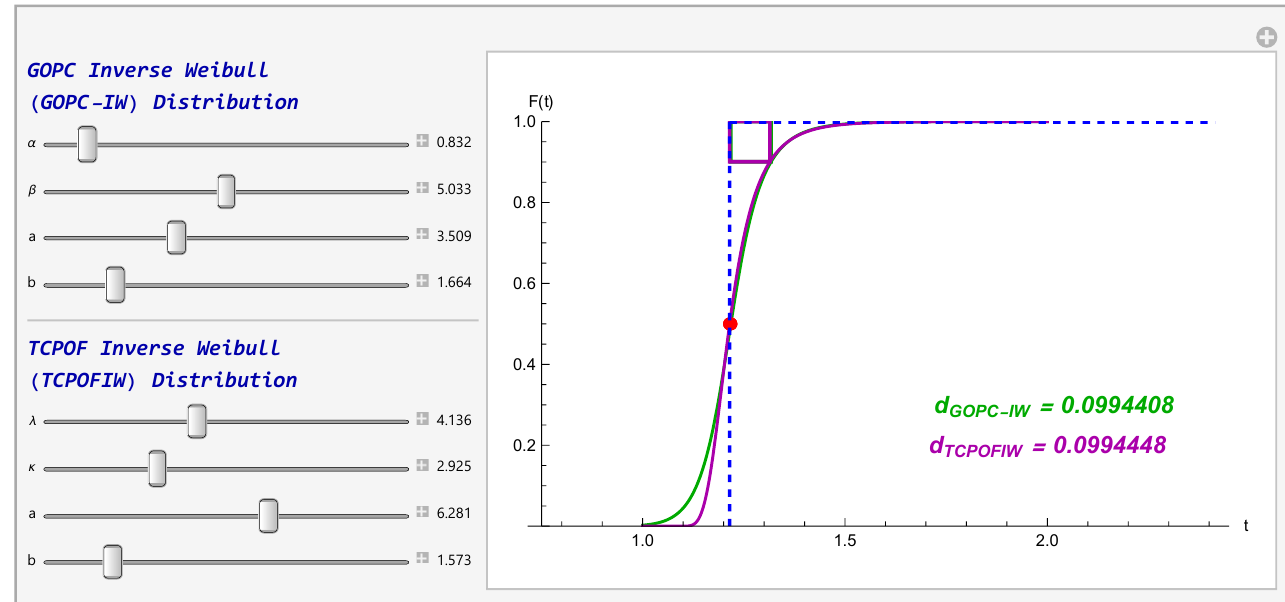
Figure 7. Hausdorff approximation of GOPC-IW and TCPOFIW